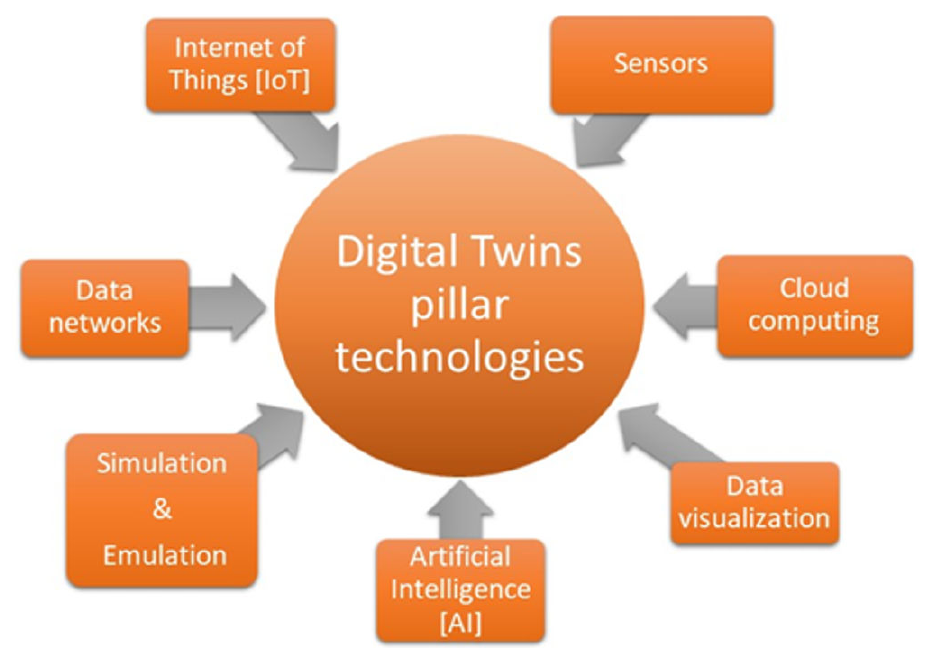
Figure 1. Digital twin pillar